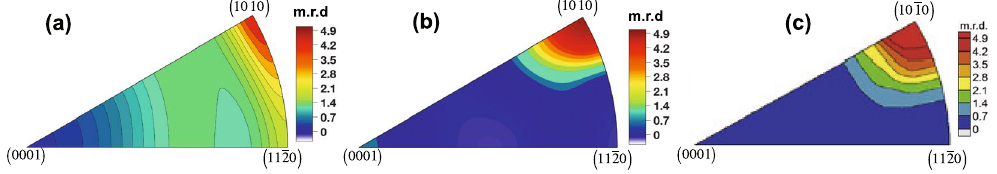
Figure 5. Inverse pole figure of the deformation texture of ω -Zr at 50% compression from the mean-field polycrystal modeling ( a , b ); and from the experiment ( c ) reproduced from Wenk et al . 2 . Critical resolved shear stress (CRSS) ratios are ( a ) all 1.0 and ( b ) are 1.0, 2.6, 2.8, and 5.0 for the prismatic-II 1010 , prismatic 〈 c 〉 , pyramidal-I 〈 a 〉 , and pyramidal-II 〈 c + a 〉 modes